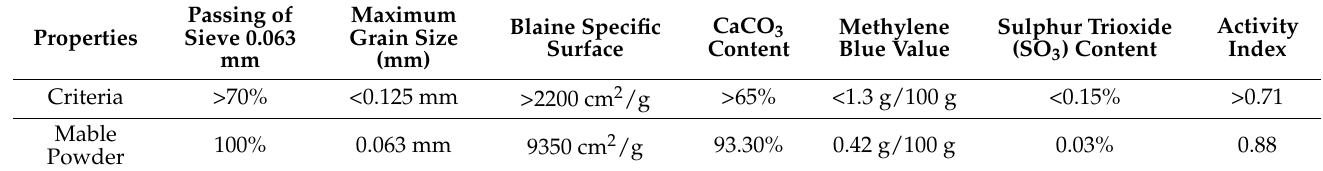
Table 5. Physical and chemical properties of mineral fillers according to standards NF